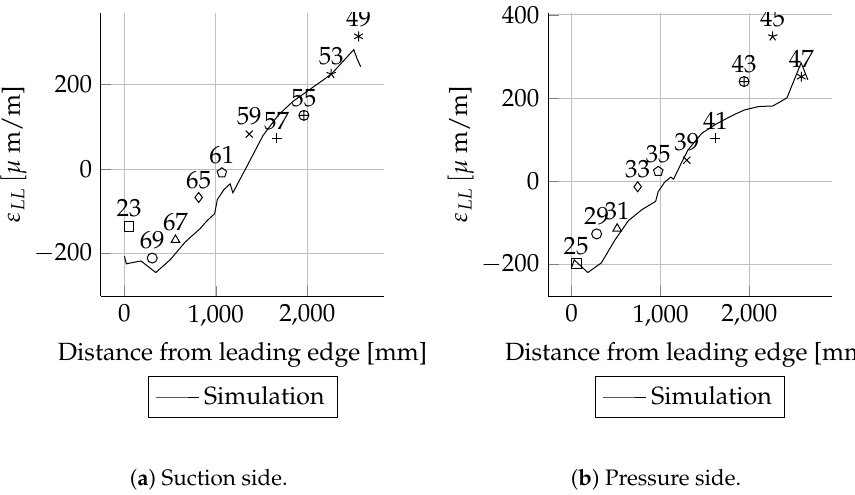
Figure A19. Strain comparison ε TT at radial position R = 5000 mm for Mxmin load case.